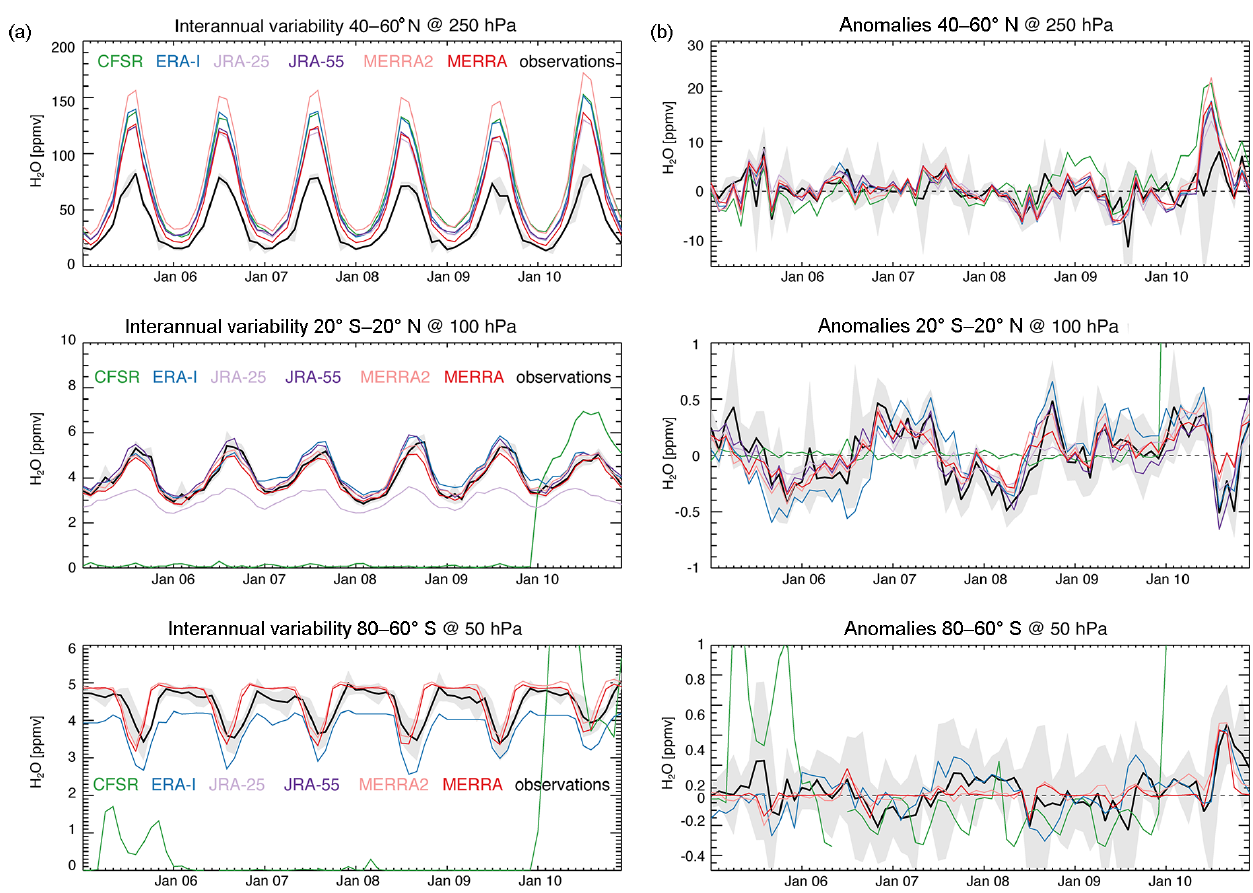
Figure 14. Interannual variability (a) and deseasonalized anomalies (b) for water vapor during 2005–2010 for the SPARC Data Initiative multi-instrument mean (SDI MIM, black) and the six reanalyses (colored). Results are shown for three different pressure levels and lati- tude ranges (top to bottom: 50hPa at 60–80 ◦ S, 100hPa at 20 ◦ S–20 ◦ N, and 250hPa at 40–60 ◦ N). Grey shading indicates observational uncertainty ( ± 1 σ ) calculated as the SD over all instruments and years